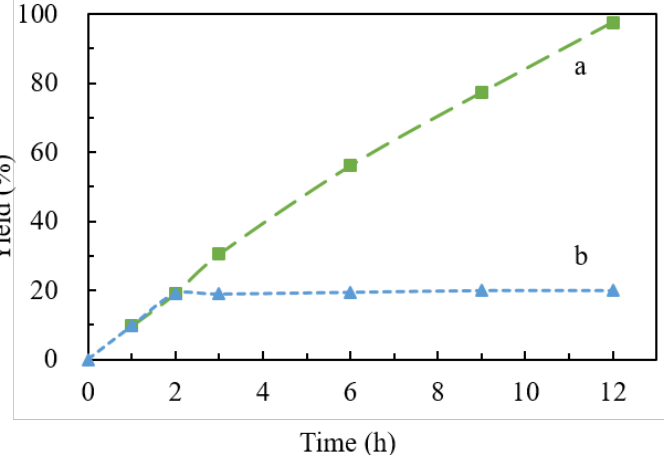
Figure 7. Time-concentration profile of the model reaction and the yield was determined by 1 H NMR with 1,3,5-trimethoxybenzene as the standard. ( a ) Reaction under the optimized conditions; ( b ) reaction after removal of Cu@N-C(600) catalyst by hot filtration at 2 h.